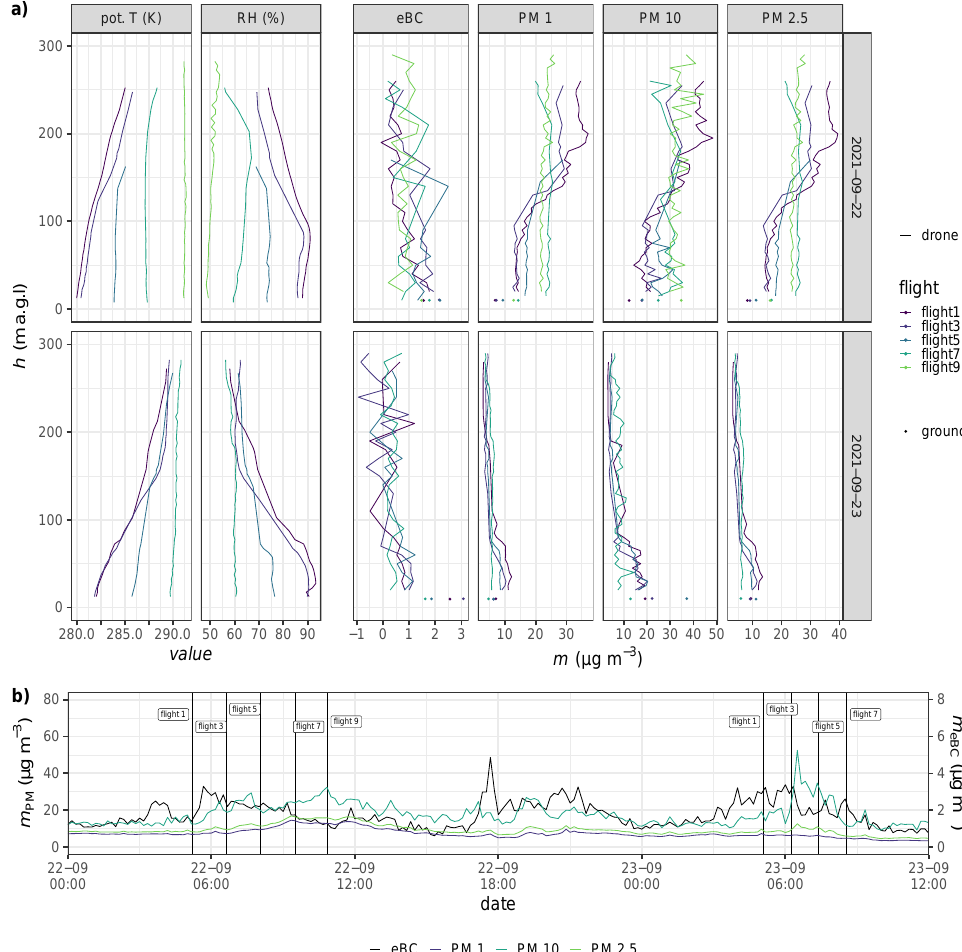
Figure 9. ( a ) Profiles of the potential temperature, ambient RH and mass concentrations of PM 1 , PM 2.5 , PM 10 and eBC derived with MesSBAR on 22 September and 23 September 2021 near Wesseling at the highway A555. Potential temperature, RH and PM i are averaged to 5-m layers, eBC to 10-m layers. Flight numbers are color-coded. Corresponding ground measurements marked as dots in their respective colors. ( b ) Times series of mass concentrations of PM 1 , PM 2.5 , PM 10 and eBC (respective colors) derived with Fidas ® 200 and AE33 (10 min average, solid lines) at BaST station. Vertical lines indicate mean time of